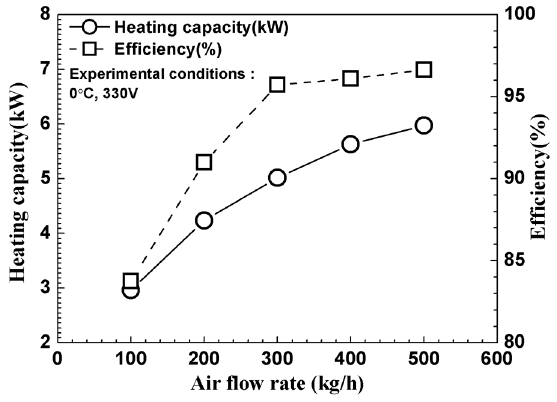
Figure 3. Variation of heating capacity and efficiency.